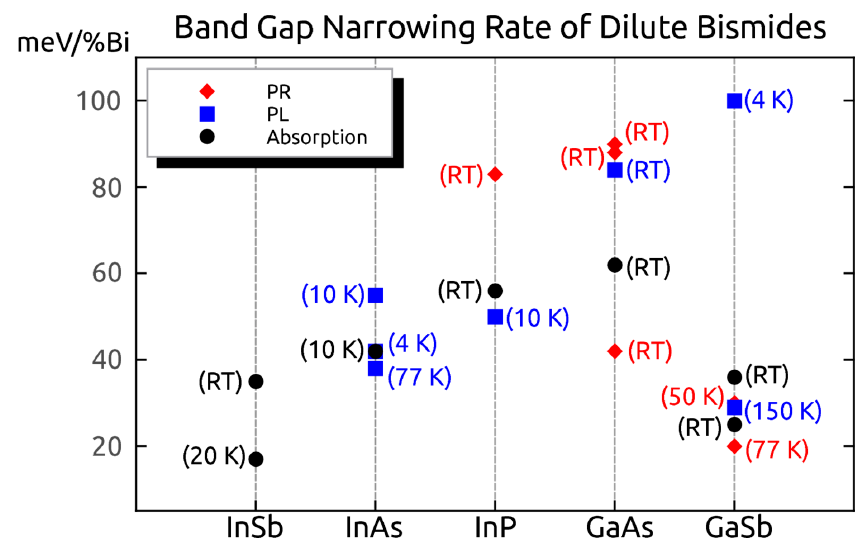
Figure 18. Summary of bandgap narrowing rate for several III-V-Bi ternaries probed by different optical spectroscopy methods. The III-V matrixes of bismides are illustrated in the bottom. The relevant references are Ref. [20,21,25,29,44,74,149,161,165,168,185,188,190,205,212,235–237].